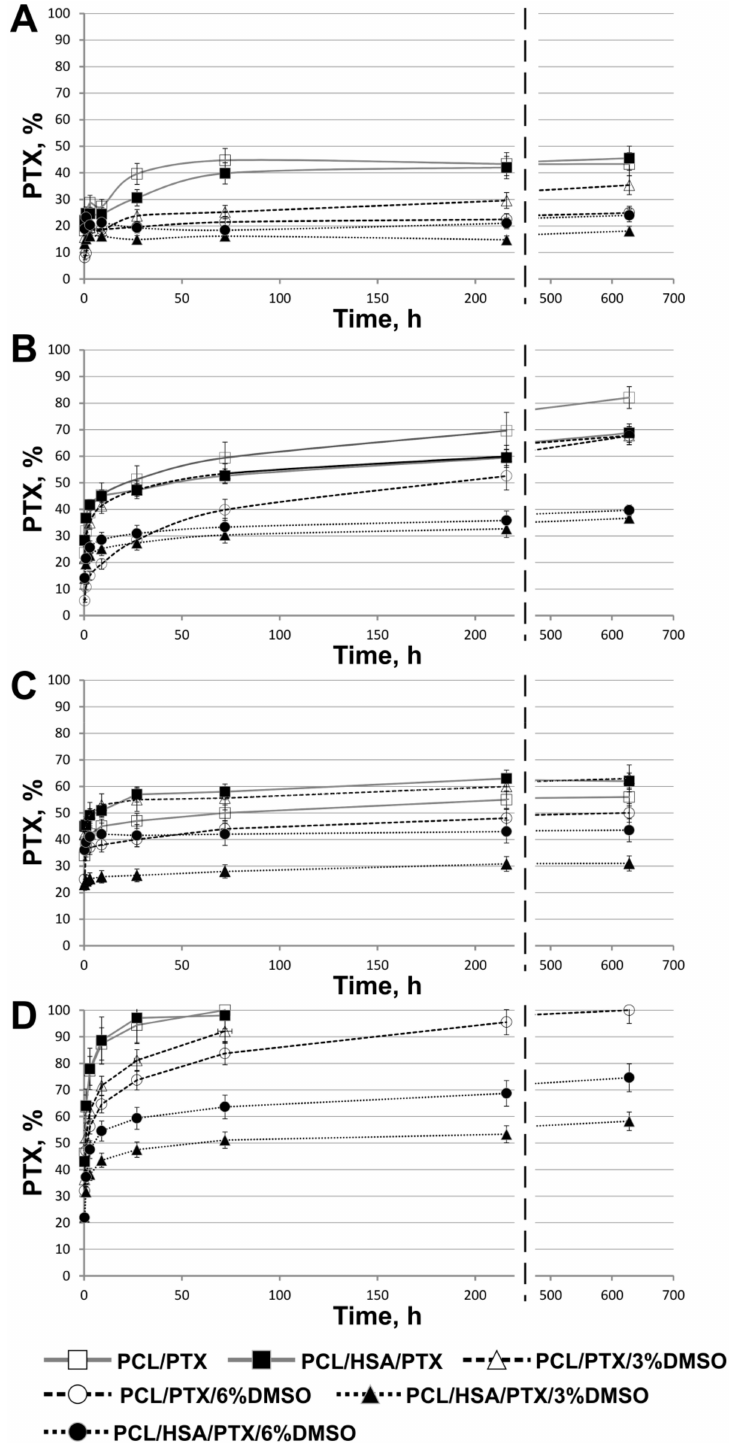
Figure 4. Kinetics of PTX release from matrices. ( A ) Incubation of 3D matrices with PBS without medium replacement; ( B ) incubation of 3D matrices with PBS with medium replacement after each time point; ( C ) incubation of 3D matrices with human plasma without medium replacement; ( D ) incubation of 3D matrices with human plasma with medium replacement after each time